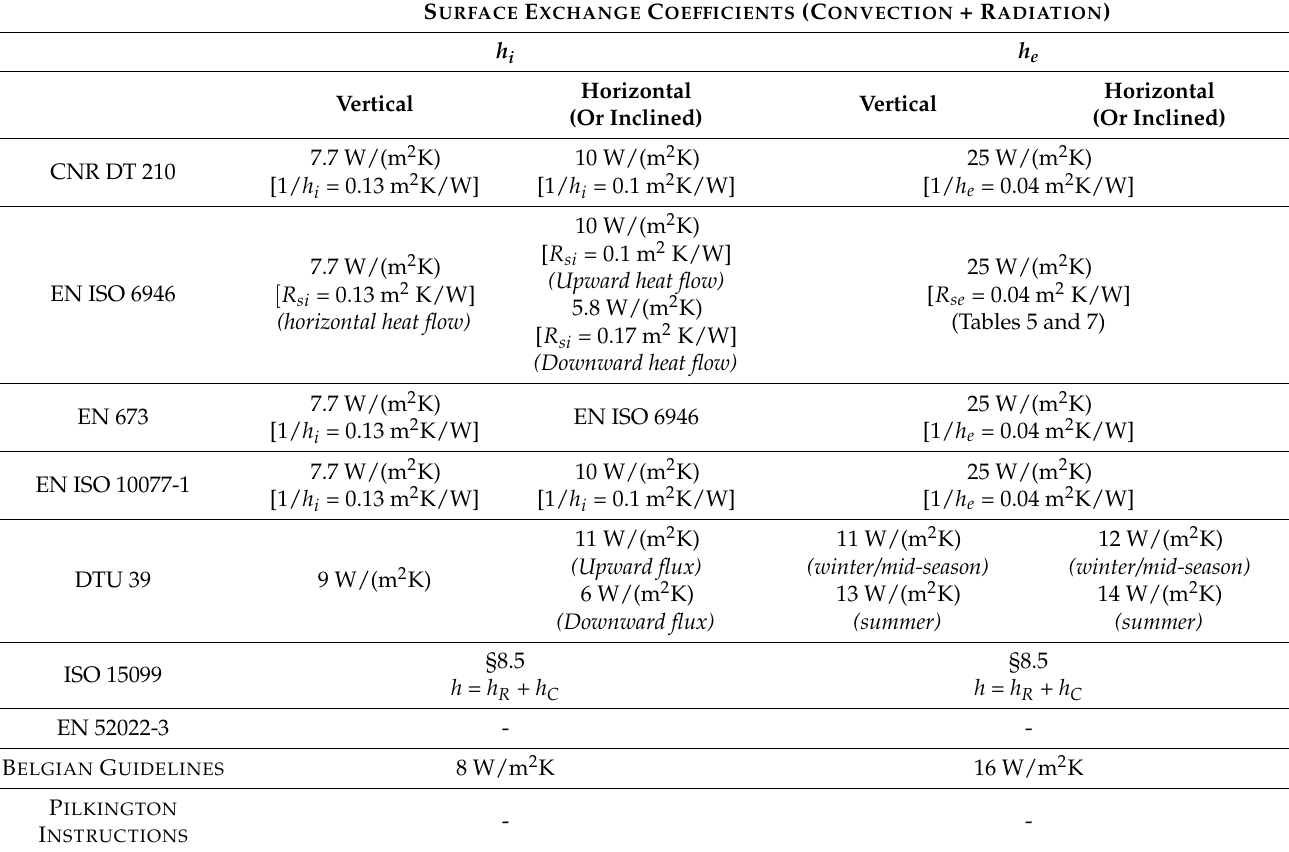
Table 3. Surface exchange coefficients according to different